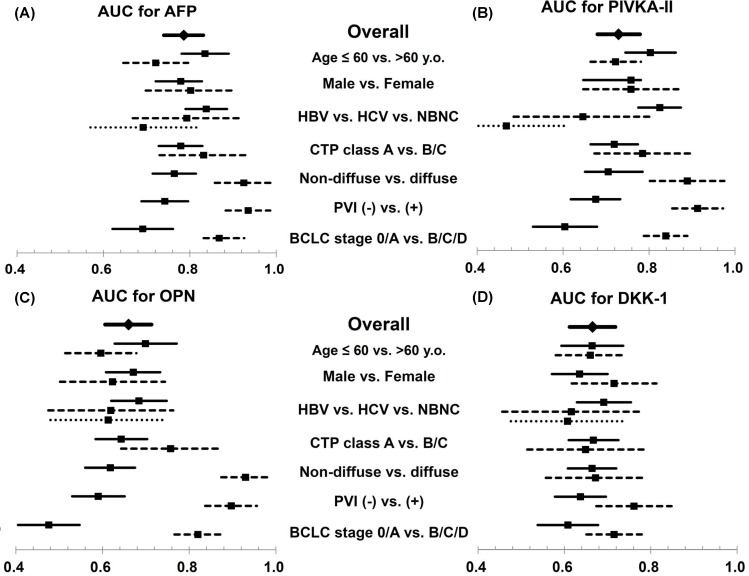
AUCs (with 95% confidence interval) for HCC diagnosis using AFP, PIVKA-II, OPN, and DKK-1 in subgroups categorized by clinical and tumor characteristics.AUCs for HCC diagnosis using AFP (A), PIVKA-II (B), OPN (C), and DKK-1 (D) were schematized to compare the effect of clinical and tumor factors on each biomarker’s diagnostic performance. The diamonds and solid bars represent the AUC and 95% CI of each marker in the total population. The squares and solid bars are the AUC and 95% CI of the first subgroup in each category (Age ≤ 60-years-old, male, HBV, CTP class A, non-diffuse HCC, PVI (-), and BCLC stage 0/A, respectively). The squares and short lined bars denote the AUC and 95% CI of the second subgroup in each category (Age > 60-years-old, female, HCV, CTP class B/C, diffuse HCC, PVI (+), and BCLC stage B/C/D, respectively). The squares and dotted bars are the AUC and 95% CI of the third subgroup in the each category (NBNC). AUC values were not obtained from multivariable analysis. Detailed AUC values with 95% CI and a direct comparison between the AUC of the four markers are presented in S2 Table.